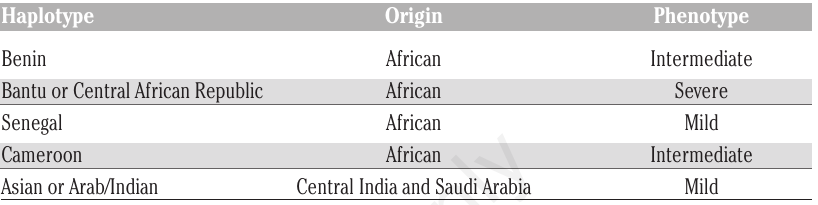
Table 1. The five most common haplotypes named after their origin and ethnic group are summarised and compared phenotypically. Haplotype